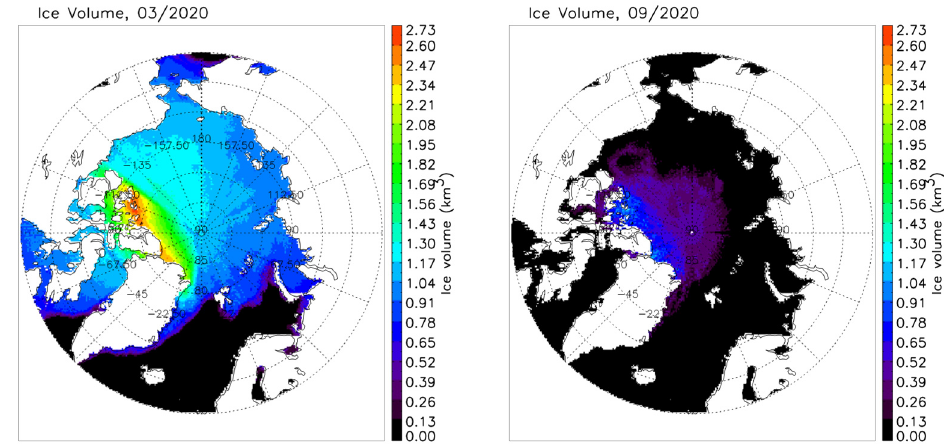
Figure 11. Spatial distributions of Arctic monthly mean SIV in March ( left ) and September ( right ) in 2020 from this study.